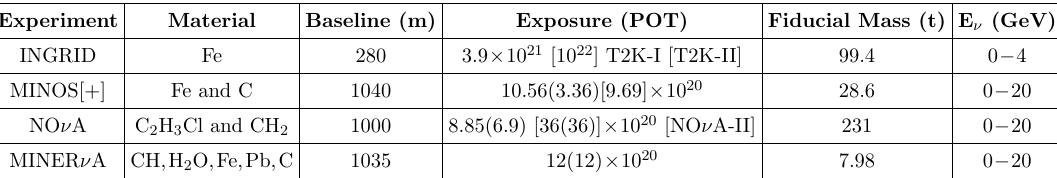
Table 6 . Summary of the non-LAr detector set-up and values used in our calculations. The POT numbers are given for a neutrino (antineutrino) beam. For T2K-I and II neutrino and antineutrino beams have the same